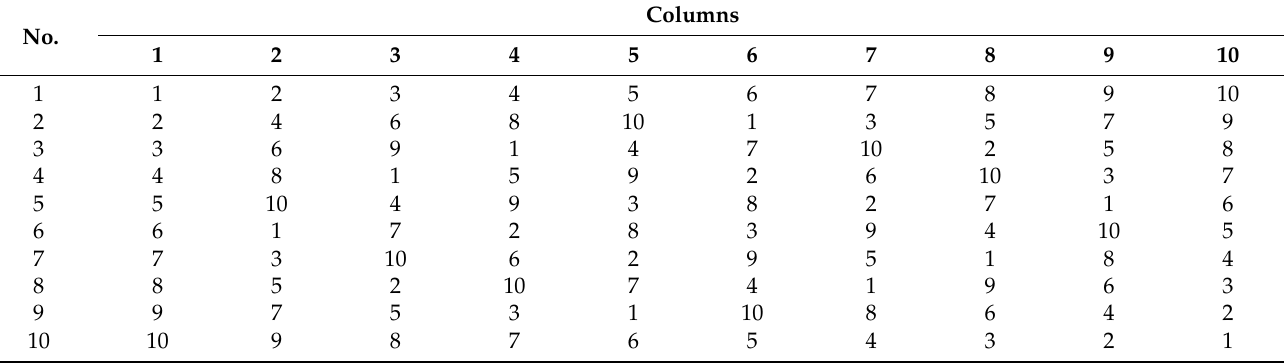
Table 2. U 10 (10 10 ) uniform